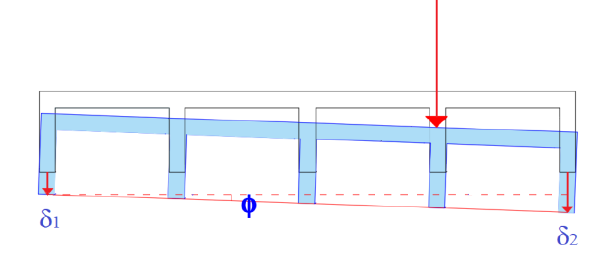
Figure 2. The displacements difference between the displacements  1 and  2 allows to obtain the transverse rotation  of the